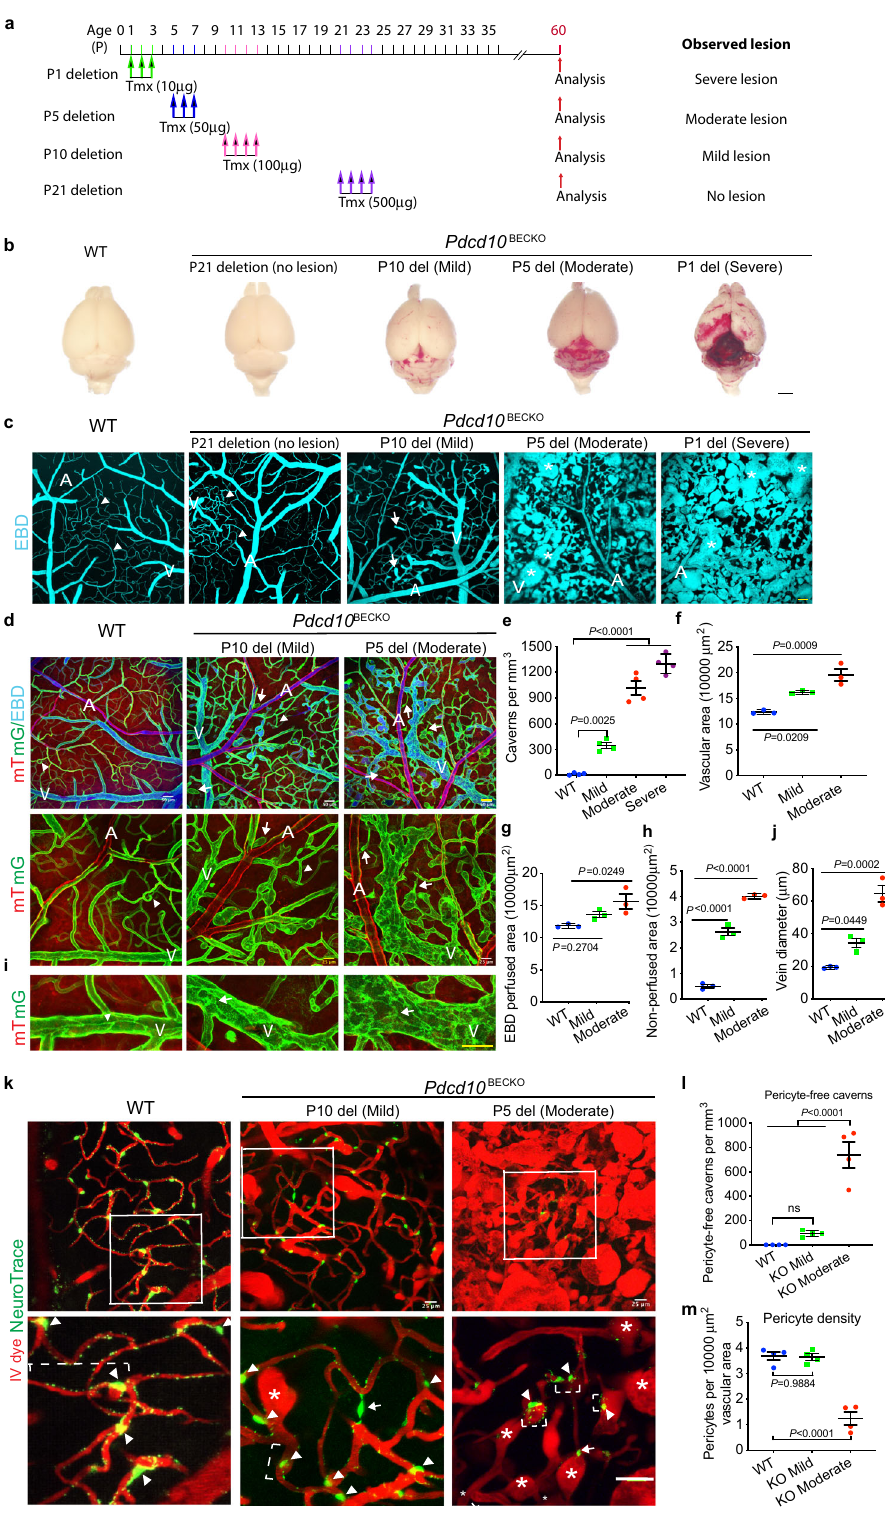
immuno fl uorescence staining. Silencing of CCM3 in HBMVEC signi fi cantly increased Cav1 and Tie2 co-localization both in the membrane-proximal region (arrow) and in intracellular vesicles (arrowhead) (Fig. 5a for high-power images; Supplementary Fig. 7a for lower power images). Cav1 siRNA diminished the surface Tie2 whereas Tie2 siRNA removed both surface and intracellular Tie2 staining (Fig. 5a). By contrast, increased Tie2 in